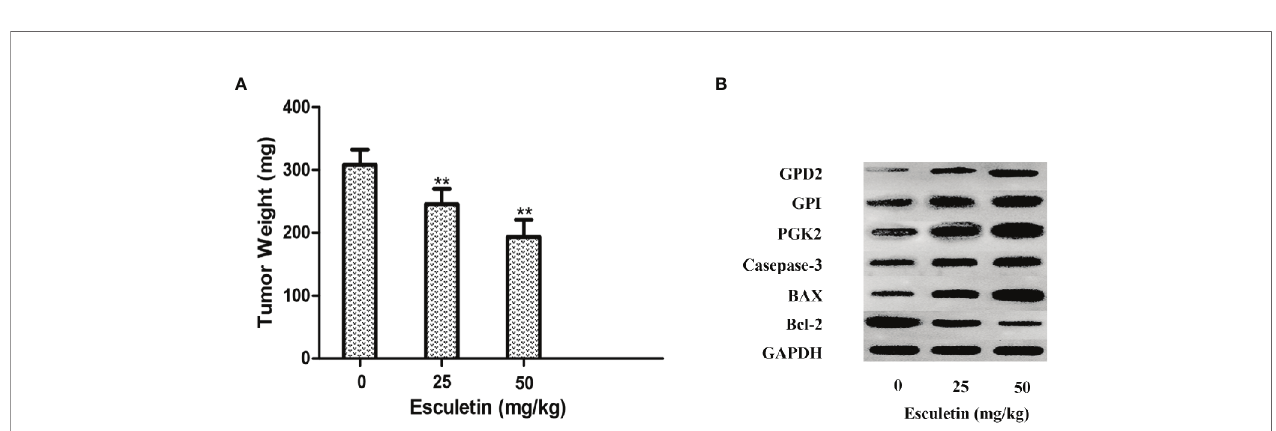
FIGURE 7 | (A) Effects of esculetin on fi nal tumor weight. (B) Comparison of PGK2, GPD2, GPI, Casepase-3, BAX, Bcl-2, and GAPDH levels in tumor tissue from different groups by WB, 0 mg/kg group was used as a control. Results are means± SEM, n=3 per experiment, *P < 0.05, **P <